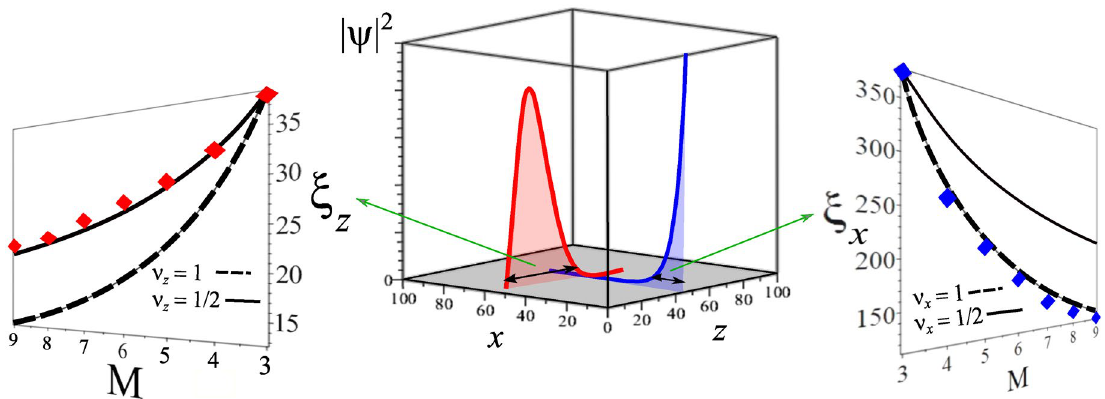
3 for the 2 and penetration depth ξ ψ Figure 7. Probability density z and ξ x as a function of M × 10 − | | Hamiltonian Eq. (9). (middle figure) In cubic perspective, we show the density probability decay behavior for the cases with open-boundary conditions along x (light blue color) and z (light red color) directions, as indicated by the axis that represent the sites along each direction. (left figure) The results from open-boundary M − ν z with conditions along the z direction ξ z (red diamonds) are well described by a correlation length ξ z ∝ 1 ν z ξ x with open-boundary conditions 2 , as shown by the black solid line. (right figure) The correlation length = 1 , see the black dashed line 47,48 along the x direction (blue diamonds) is in turn well described by ν x =